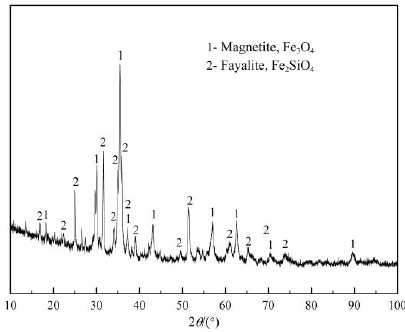
Figure 1. XRD patterns of the received copper slag.